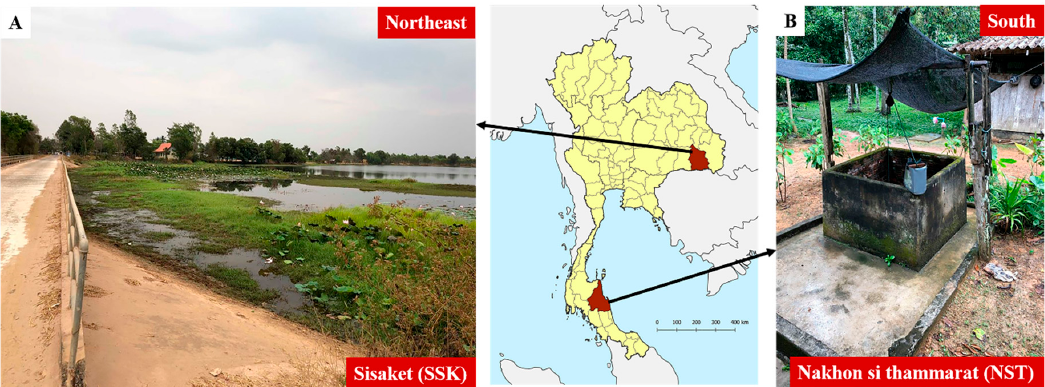
Figure 1. Typical shared water sources: ( A ) a natural water source with an open system, in the northeast; ( B ) a ground-water well owned by a household and situated close to or within the house, in the south. Samples were collected from environmental water sources surrounding households.